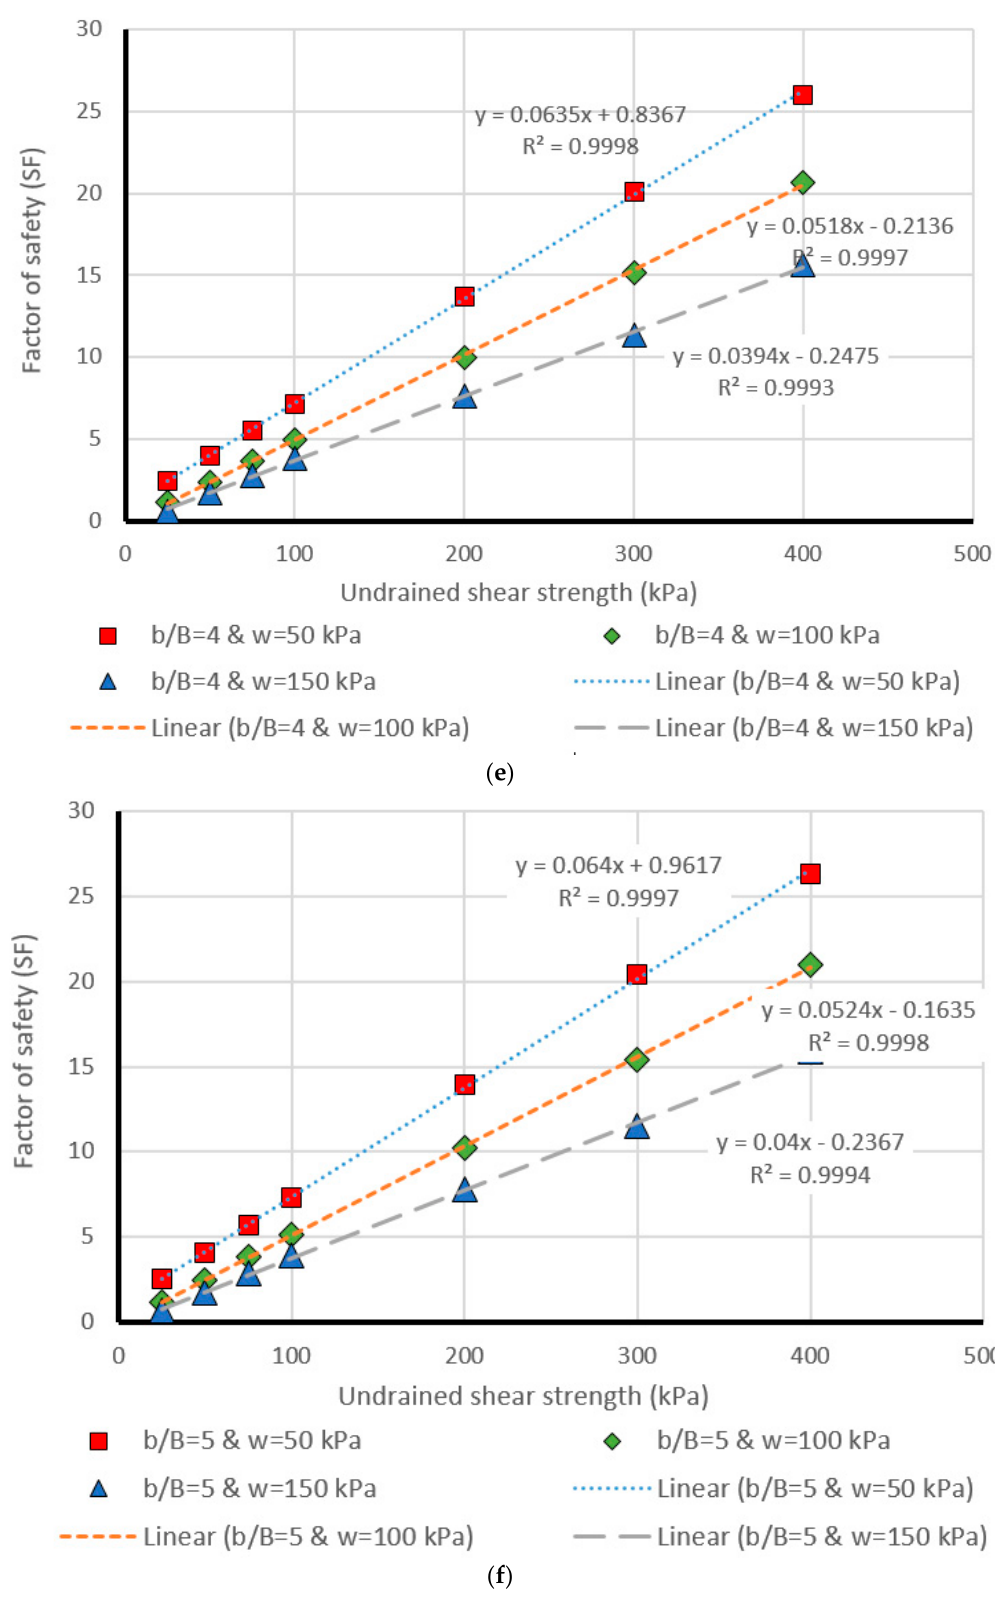
Figure 8. Comparison of the MLP estimation and real values of FS for the β = 15°, ( a ) b/B = 0, ( b ) b/B = 1, ( c ) b/B = 2, ( d ) b/B = 3, ( e ) b/B = 4, ( f ) b/B = 5.